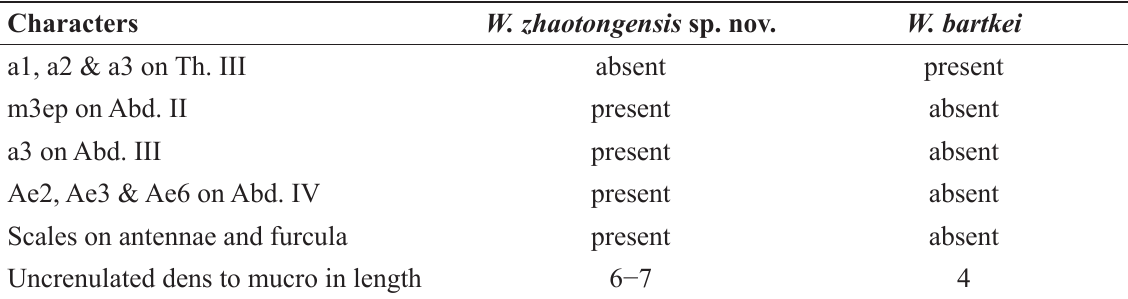
Table 2. Comparison of W. zhaotongensis sp. nov. and W. bartkei